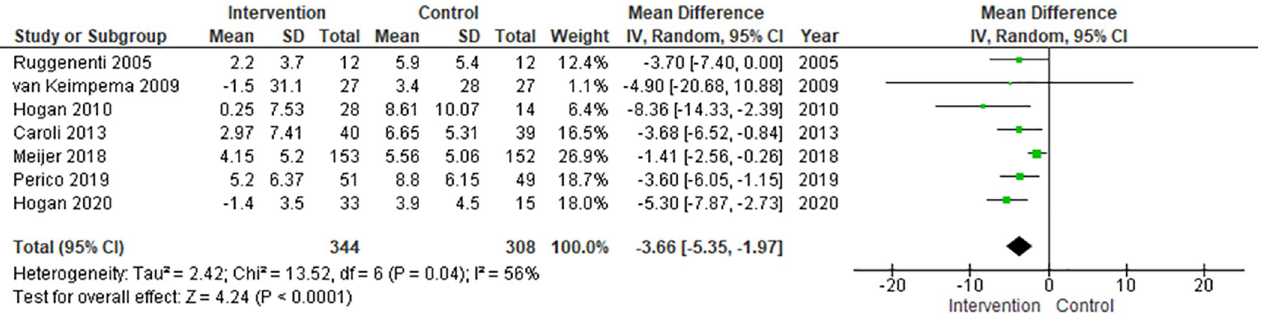
Fig 3. Meta-analysis of